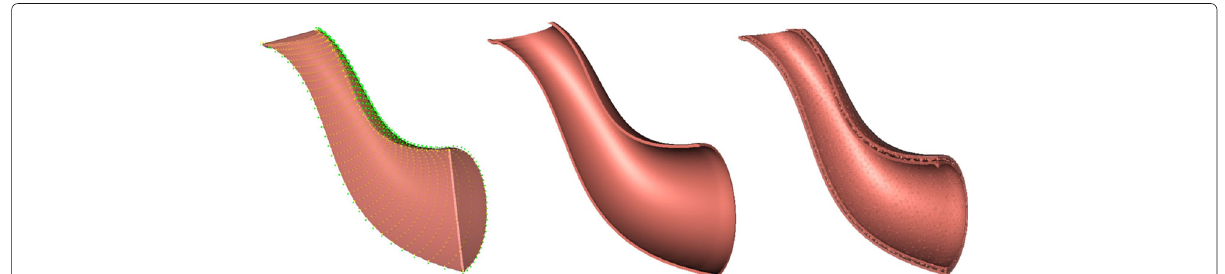
Fig. 2 Implicit Utah teapot spout obtained by fitting a point cloud sampled from the classic Utah teapot model. Left: the sampled point cloud; Middle: The implicitly represented thin-solid teapot spout surface; Right: The implicitly represented thin-solid teapot spout with an interior porous material